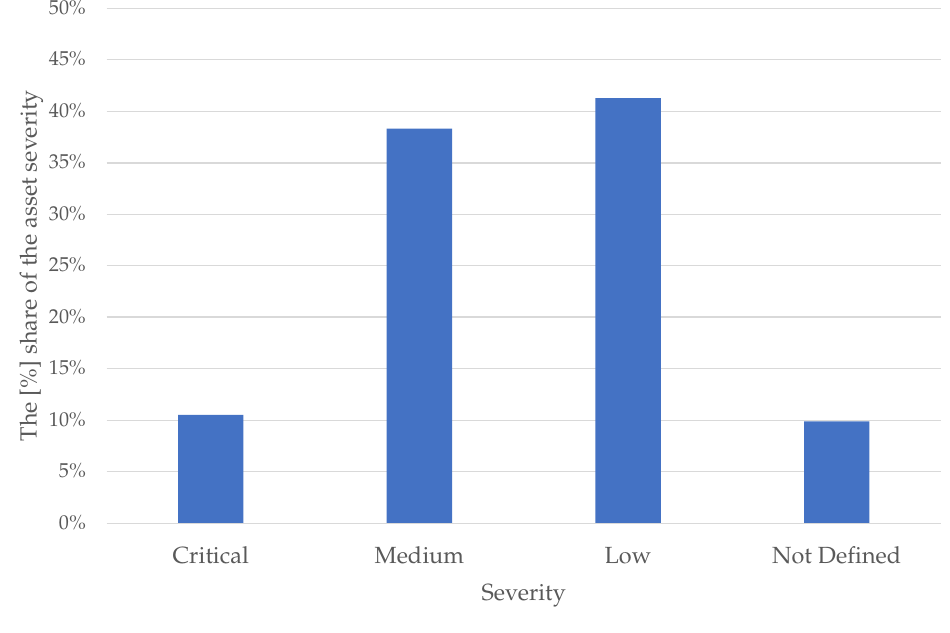
Figure 7. Asset criticality histogram for environment